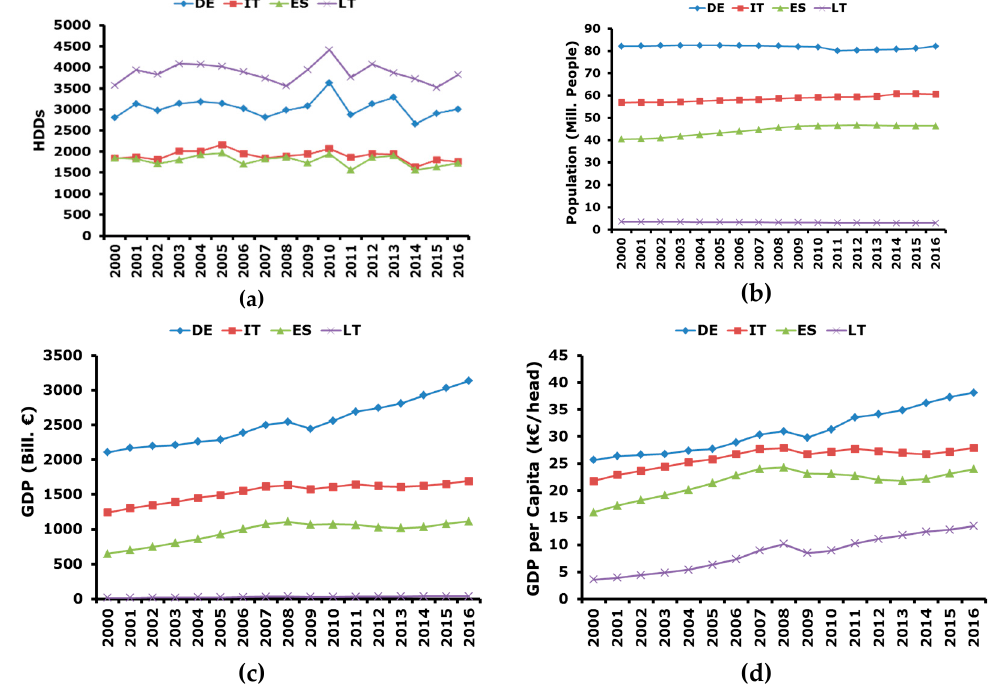
Figure 2. Trend of relevant climatic and macro-economic variables determining energy consumption: ( a ) heating degree days (HDDs); ( b ) population; ( c ) gross domestic product (GDP); ( d ) GDP per capita.